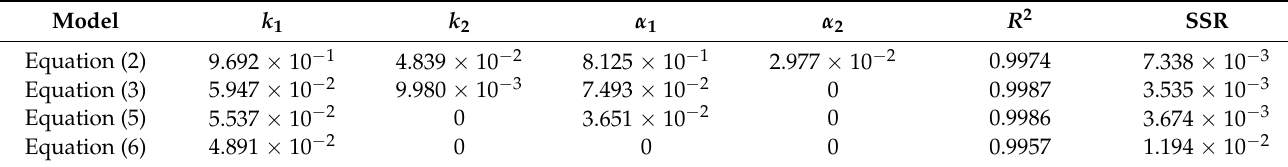
Figure 5. Decline of relative enzyme activity over operation time during the five consecutive cycles. Symbols represent data obtained by using different saccharides fractions in the estimation procedure. Predictions obtained by inactivation models are illustrated with lines.